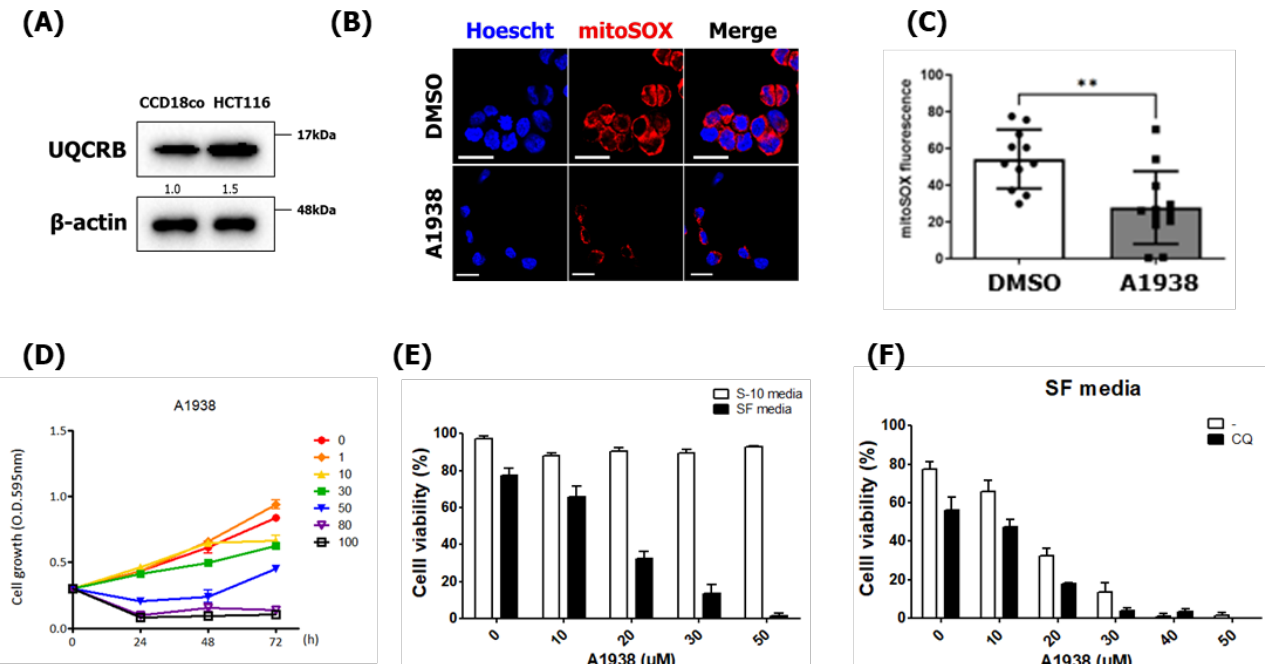
Figure 1. A1938-induced cell death is sensitized in HCT116 cells. ( A ) Expression levels of UQCRB in CCD18co normal human colon cells and HCT116 CRC cells. β -actin was used as an internal control. The relative band intensities value was normalized to β -actin (loading control). The normalized protein levels are shown under each band. ( B ) Confocal microscopy images of MitoSOX Red fluorescence showing mROS generated in HCT116 cells. ( C ) The mean ± SD of cells ( n = 11) treated with 30 µM A1938 for 4 h. Scale bar, 20 µm. ( D ) HCT116 cell viability after treatment with 0, 1, 10, 30, 50, 80, or 100 µM A1938 as assessed using the MTT assay. ( E ) The viability of A1938-treated HCT116 cells using concentrations of 0, 10, 20, 30, or 50 µM in the trypan blue assay. S -10 media means medium containing 10% serum, and SF media does medium without the serum. SF media have been used for establishing the serum-starvation conditions. ( F ) HCT116 cell viability as measured using ImageJ software after treatment with 0−50 µM A1938 in the presence or absence of 5 µM chloroquine for 3 days in a serum- free medium. Statistical significance was assessed using the Student’s t -test. ** p < 0.01.